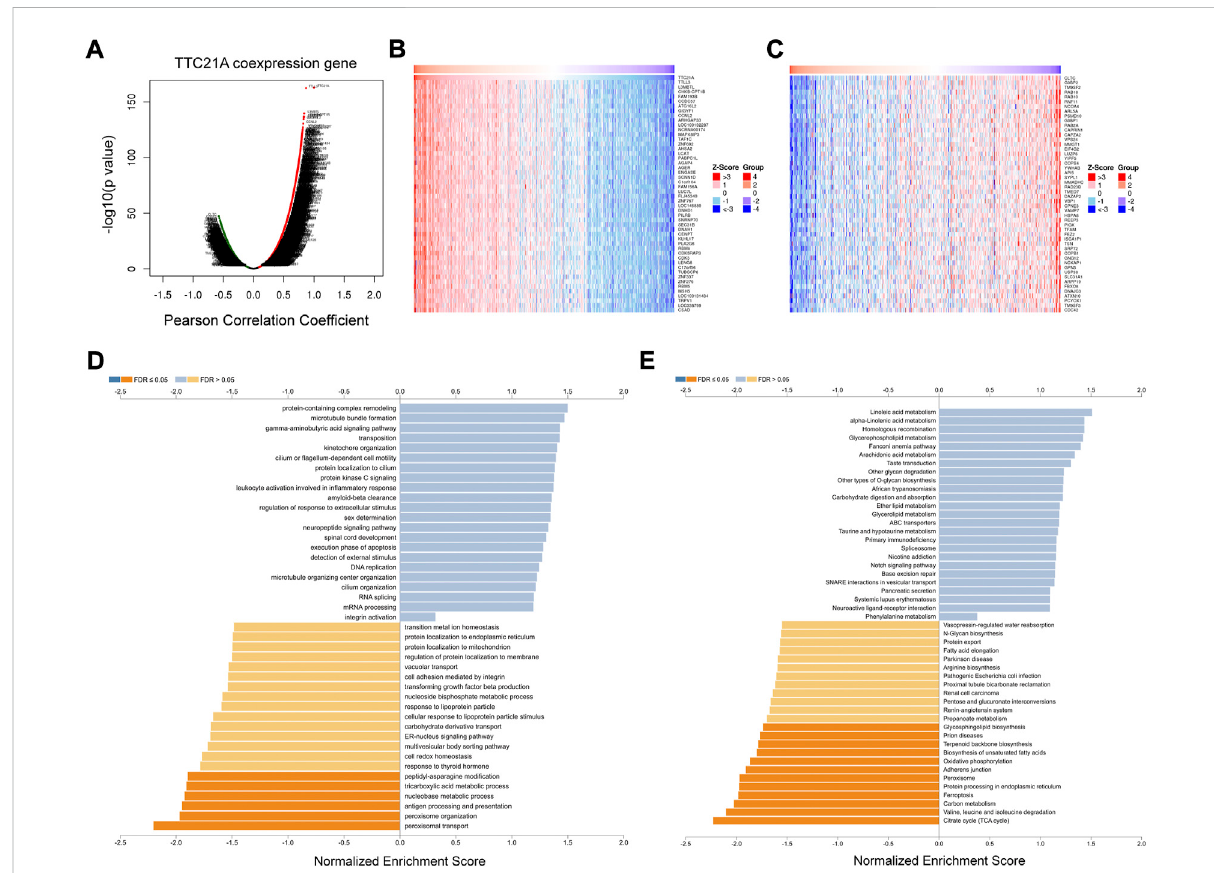
FIGURE 6 Analysis of the co-expression genes of TTC21A in ccRCC. (A) The co-expression genes of TTC21A in ccRCC. (B) Heat map of top 50 genes positively correlated with TTC21A (C) Heat map of top 50 genes negatively correlated with TTC21A. (D) Enrichment analysis of the co-expression genes in biological process of ccRCC. (E) Enrichment analysis of the co-expression genes in KEGG pathway of